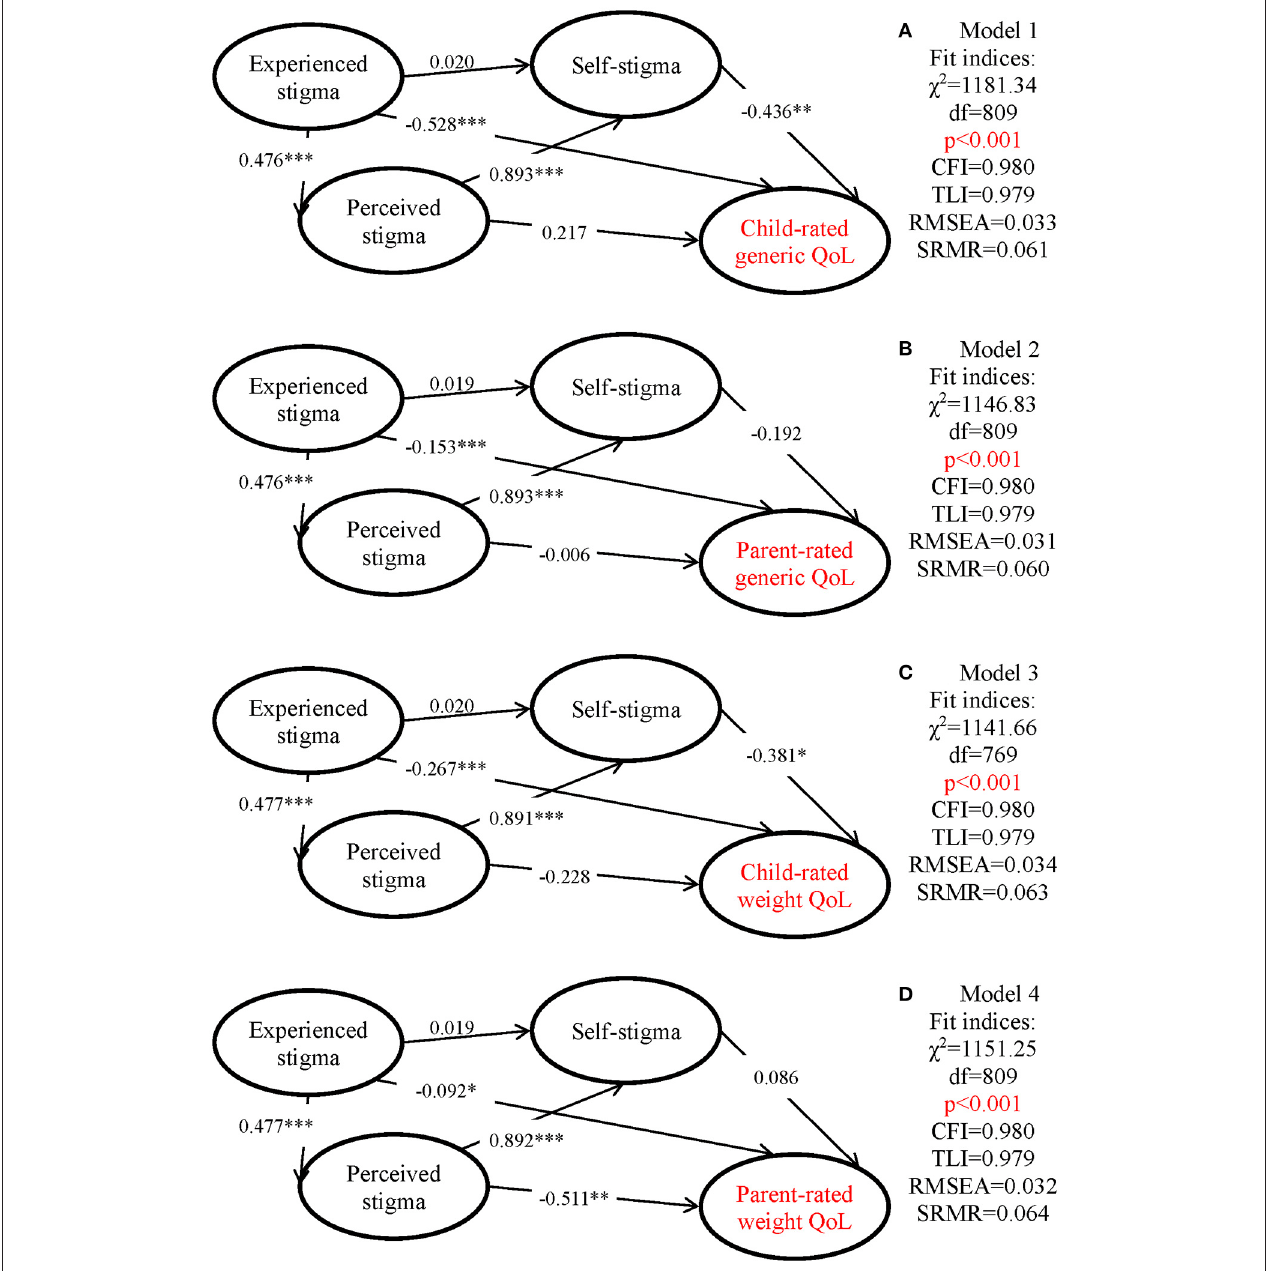
FIGURE 1 | Proposed models evaluating different types of weight bias on quality of life (QoL) with standardized path coefficients. (A) Model 1: QoL assessed using child-reported generic instrument (Kid-KINDL). (B) Model 2: QoL assessed using parent-reported generic instrument (Kid-KINDL). (C) QoL assessed using child-reported weight-related instrument (Sizing Me Up). (D) QoL assessed using parent-reported weight-related instrument (Sizing Them Up). All models controlled age, gender, and body mass index. CFI, comparative fit index; TLI, Tucker-Lewis index; RMSEA, root mean square error of approximation; SRMR, standardized root mean square residual. * p < 0.05; ** p < 0.01; *** p <